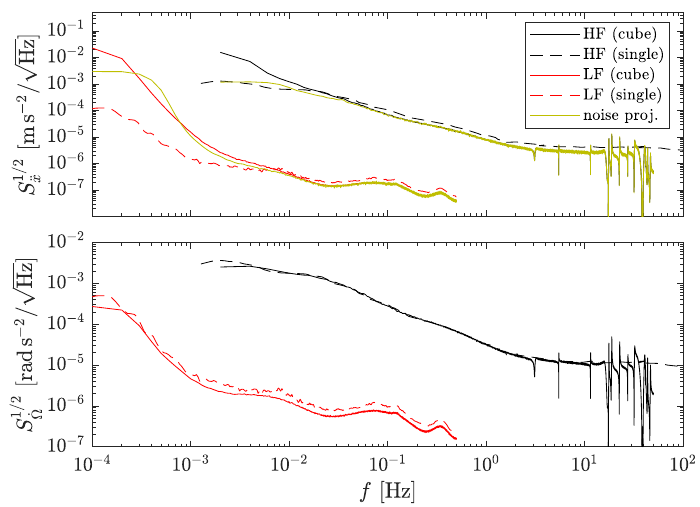
Figure 6. Top: Linear acceleration performance. Bottom: angular acceleration. Cube indicates GF-INS configuration with (cid:96) = 0.25cm, while single corresponds to the acceleration noise of an optomechanical accelerometer, i.e., the same curves shown in Figure 2. HF: high-frequency. LF: